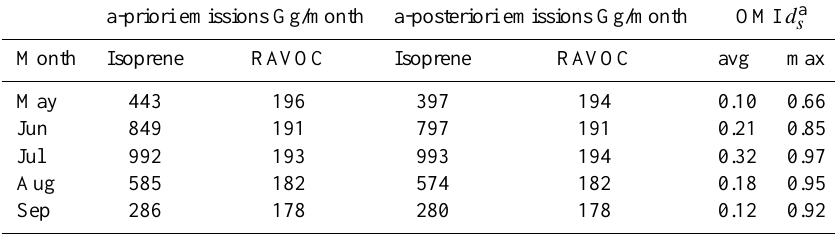
Table 2. A-priori and a-posteriori (OMI-derived) European VOC emissions in 2005. RAVOCs are anthropogenic reactive VOCs (ethene, propene and xylenes). a-priori emissions Gg/month OMI d a s Isoprene